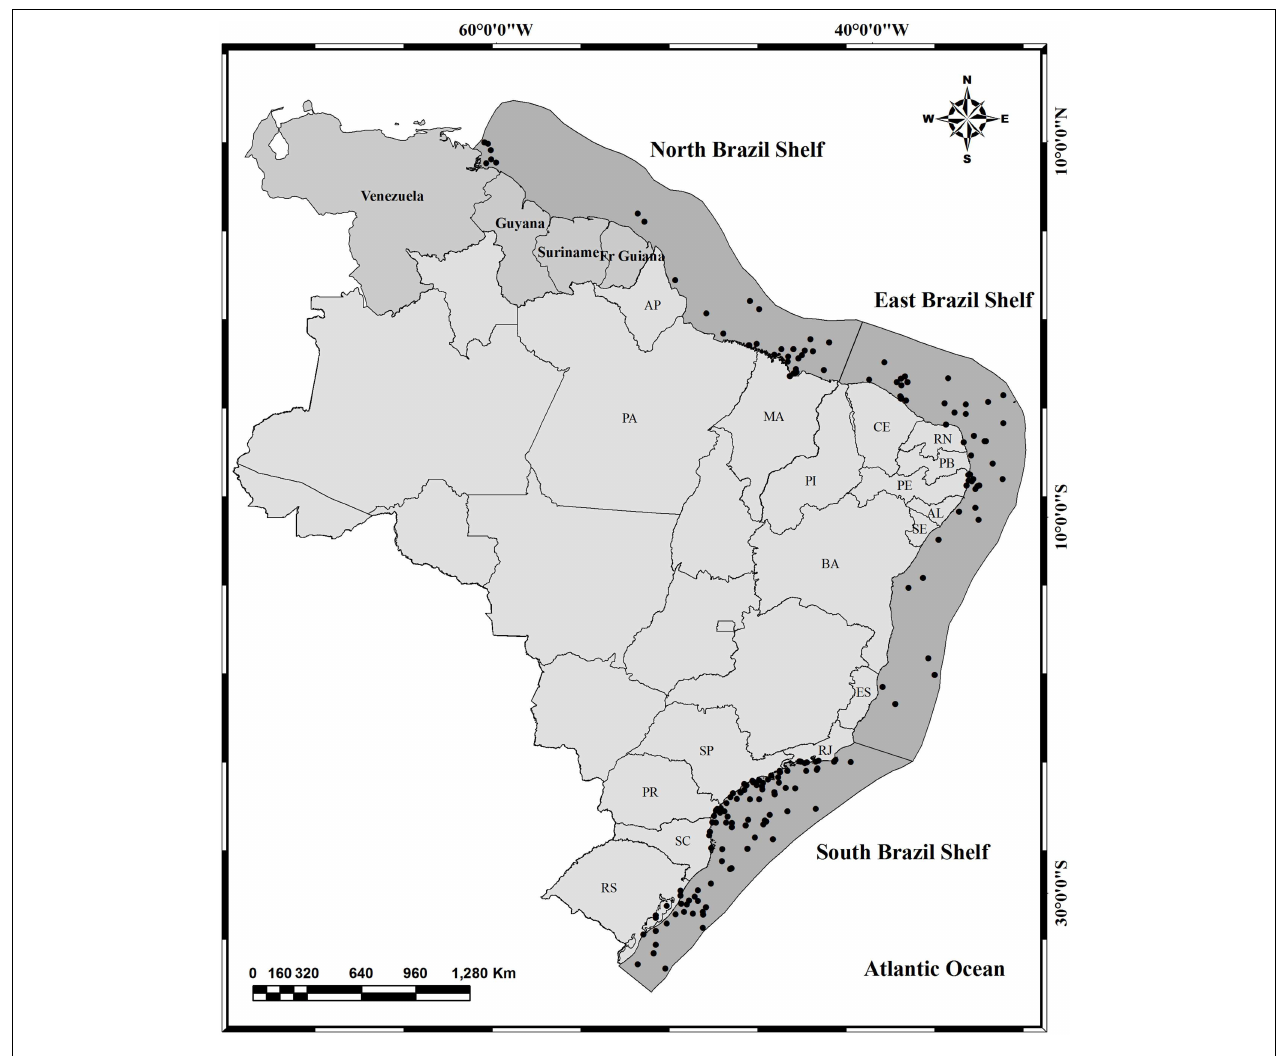
states are: Amapá (AP), Pará (PA), Maranhão (MA), Piauí (PI), Ceará (CE), Rio Grande do Norte (RN), Paraíba (PB), Pernambuco (PE), Alagoas (AL), Sergipe (SE), Bahia (BA), Espírito Santo (ES), Rio de Janeiro (RJ), São Paulo (SP), Paraná (PR), Santa Catarina (SC), and Rio Grande do Sul